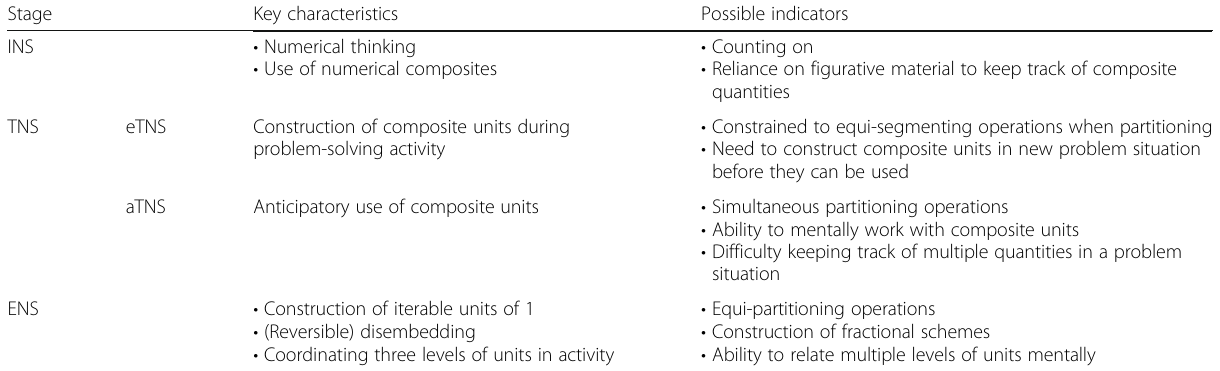
Table 1 Summary of key stages investigated Stage Key characteristics Possible